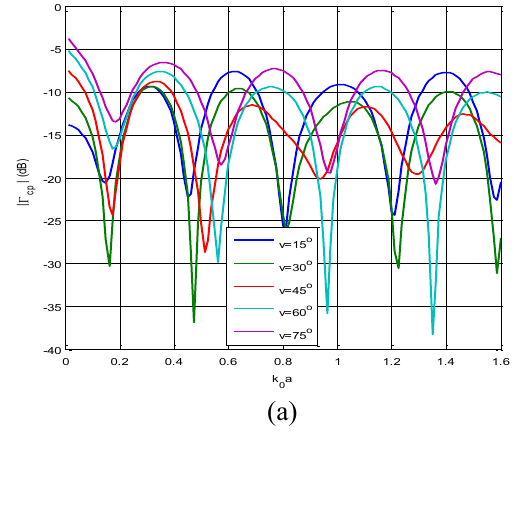
Fig. 3. Variations of the magnitudes of reflection coefficients versus k a for buried PEMC circular 0 cylinders of radius a , with  = 2.0, d = 2.25 cm, r for different values of ν ; (a) co-polar coefficient; a for buried PEMC 0 (b) cross polar  =2.0, r